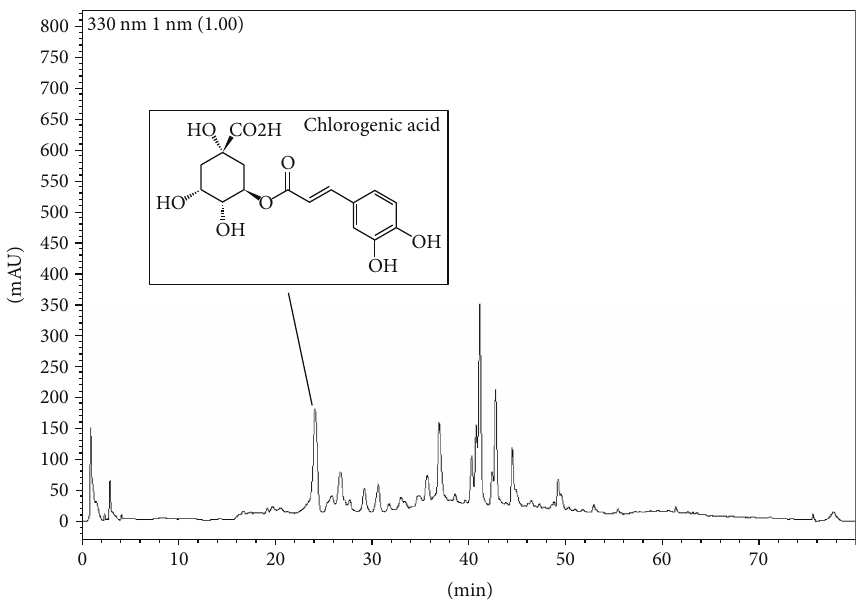
Figure 6: High-performance liquid chromatography (HPLC) fi ngerprint analysis of APO. The APO components in 100% methanol were determined through an HPLC system for fi ngerprint analysis as mentioned in Section 2.14. APO: A. princeps